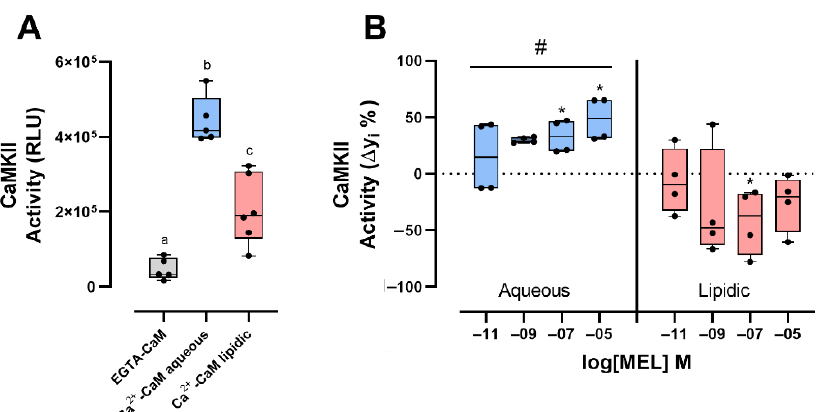
Figure 4. Calmodulin kinase II activity determined in the presence of melatonin. ( A ) Basal calmodulin kinase II (CaMKII) activity in the presence of calmodulin (CaM) with EGTA or Ca 2+ in aqueous or lipidic microenvironment. ( B ) Percentage of the difference ( ∆ y i %) between CaMKII basal activity and the activity of CaMKII assessed in the presence of Ca 2+ -CaM and four melatonin (MEL) concentrations (10 − 11 , 10 − 9 , 10 − 7 , 10 − 5 M) in aqueous or lipidic media. Zero is the activity of CaMKII determined with Ca 2+ -CaM and the vehicle (Illustrated as a punctuated line). A one-way or two-way ANOVA and a Tukey multiple comparisons test were performed. Significant differences ( p < 0.05) between the vehicle (aqueous or lipidic) and different MEL concentrations are indicated with (*), and (#) indicates global differences between aqueous and lipidic environments. Different literals p < 0.05. Results are represented as box and whiskers with the median, first and third quartile with maximum and minimum values of at least 4 experimental repetitions.